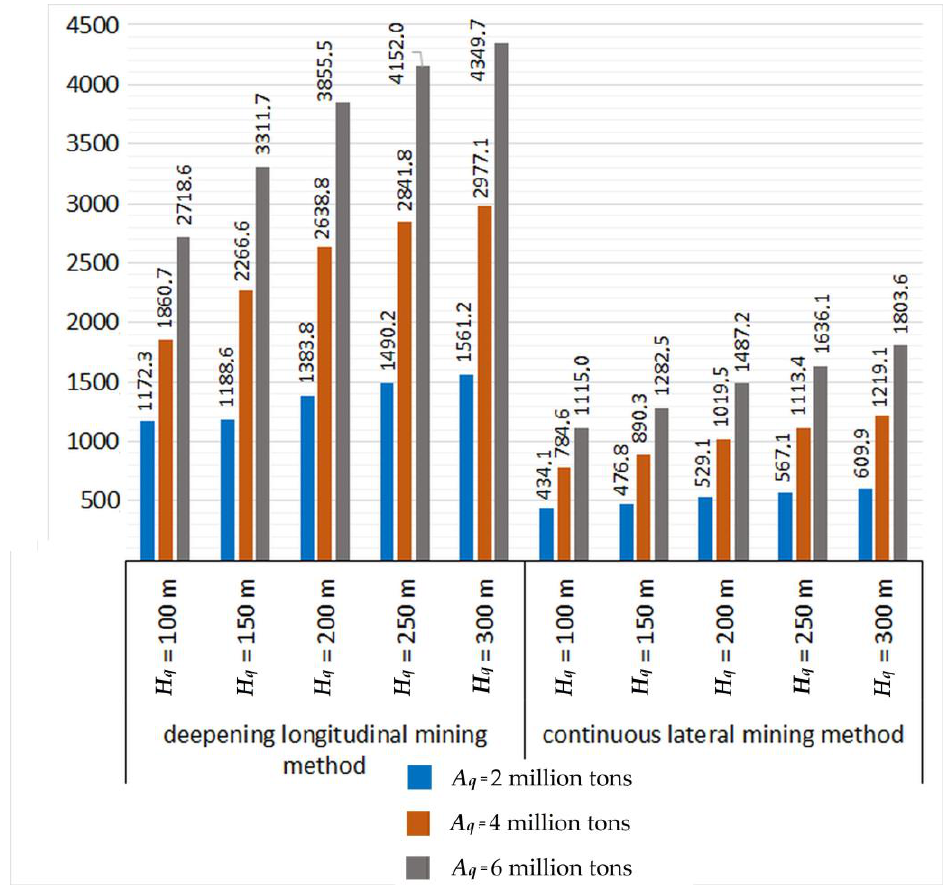
Figure 12. Comparison of the total costs of overburden transporting for deepening longitudinal and continuous lateral mining methods.